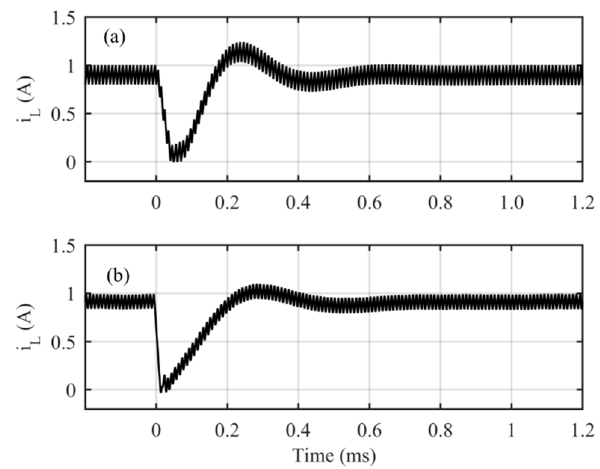
Figure 15. The comparison of the behavior of inductor currents in CCR when the maximum step size (i.e., 0.71) is applied: ( a ) Simulated behavior, and ( b ) experimentally measured behavior.